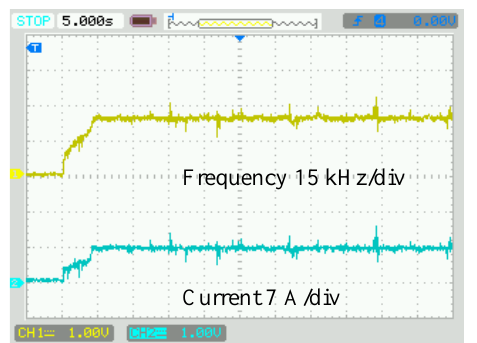
Figure 12. Performance of PO algorithm for scenario III